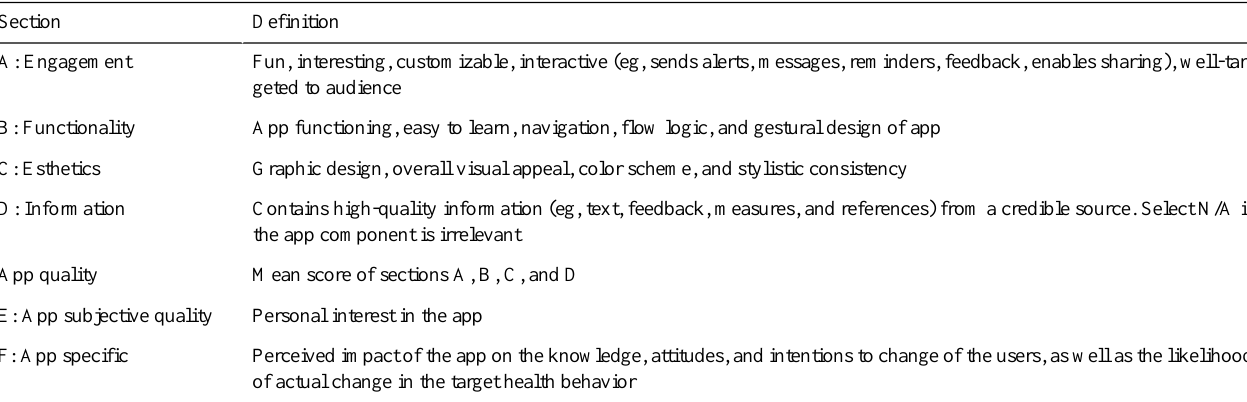
Table 1. Structure of the